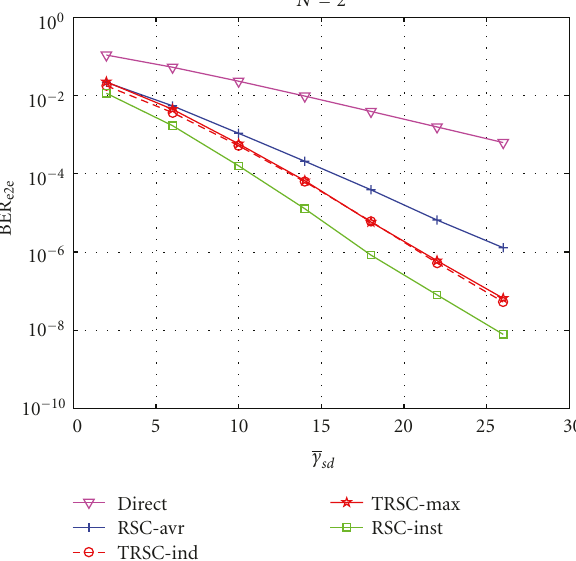
Figure 4: Threshold values that minimize e2e BER of TRSC in symmetric networks with di ff erent numbers N of relays.